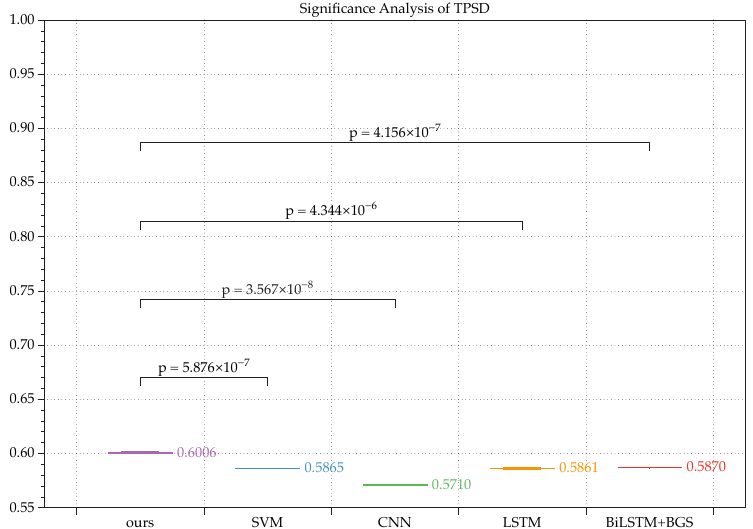
Figure 10. The paired t -test significance analysis of TPSD. We compared the group of our MCH values with other four methods. Each group of TPSD values was obtained by five runs of the corresponding